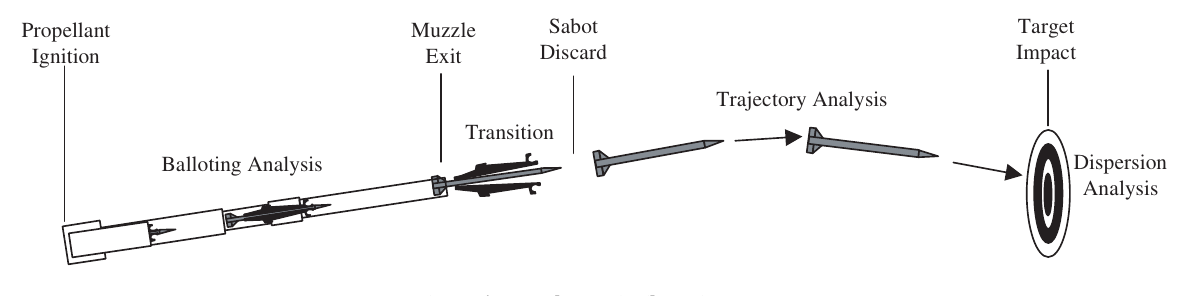
Fig. 1. The complete projectile